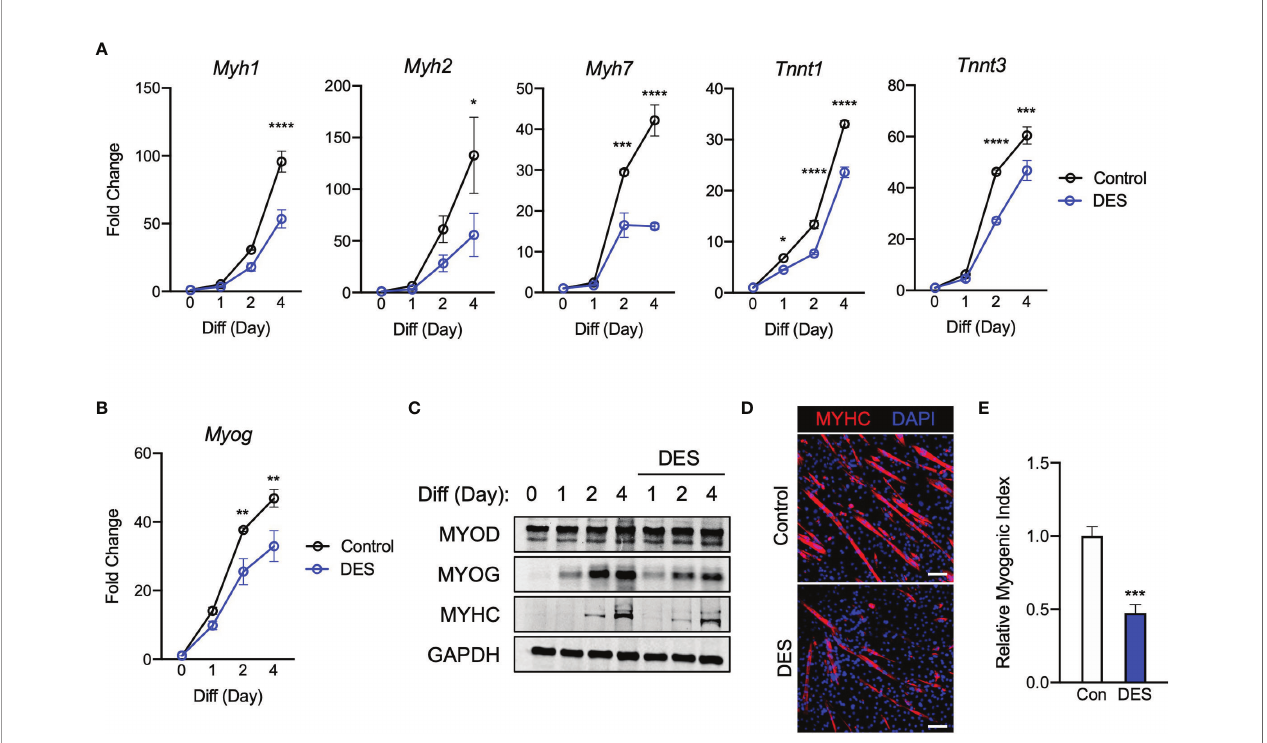
FIGURE 5 | Elevated exposure to succinate elicits inhibition of C2C12 myogenesis via mechanism similar to those observed when exposing cells to itaconate and malonate. (A) 4-day time course showcasing fold change differences of myogenic gene transcription levels detected via RT-qPCR when exposed to differential media with or without diethyl succinate (DES: 5 mM) relative to the untreated group (n = 3). (B) Fold change of Myog expression at various time points comparing DM control groups to DM and DES groups relative to expression without either treatment (n = 3). (C) Western blotting data showing differences in myogenic transcription factor expression between DM treated groups and groups treated with both DM and DES over a 4 day time course as well as groups which were not exposed to either treatment for any period. (D) MYHC staining at day 4 of differentiation. Bar: 100 m m. (E) Relative myogenic index (percentage of total nuclei associated with myotubes). * denotes p< 0.05, ** p <0.01, *** p <0.001, **** p <0.0001 compared to control based on